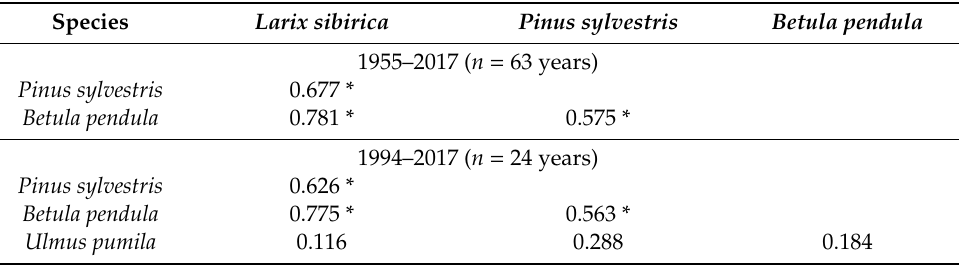
Table 2. Inter-species correlation coe ffi cients between the standard TRW